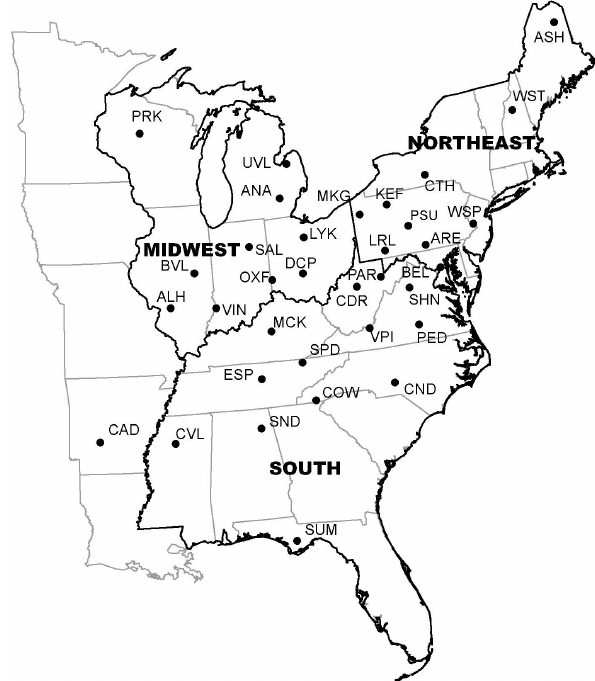
Figure 2. CASTNET monitoring sites and geographical regions considered in the current study (see Table